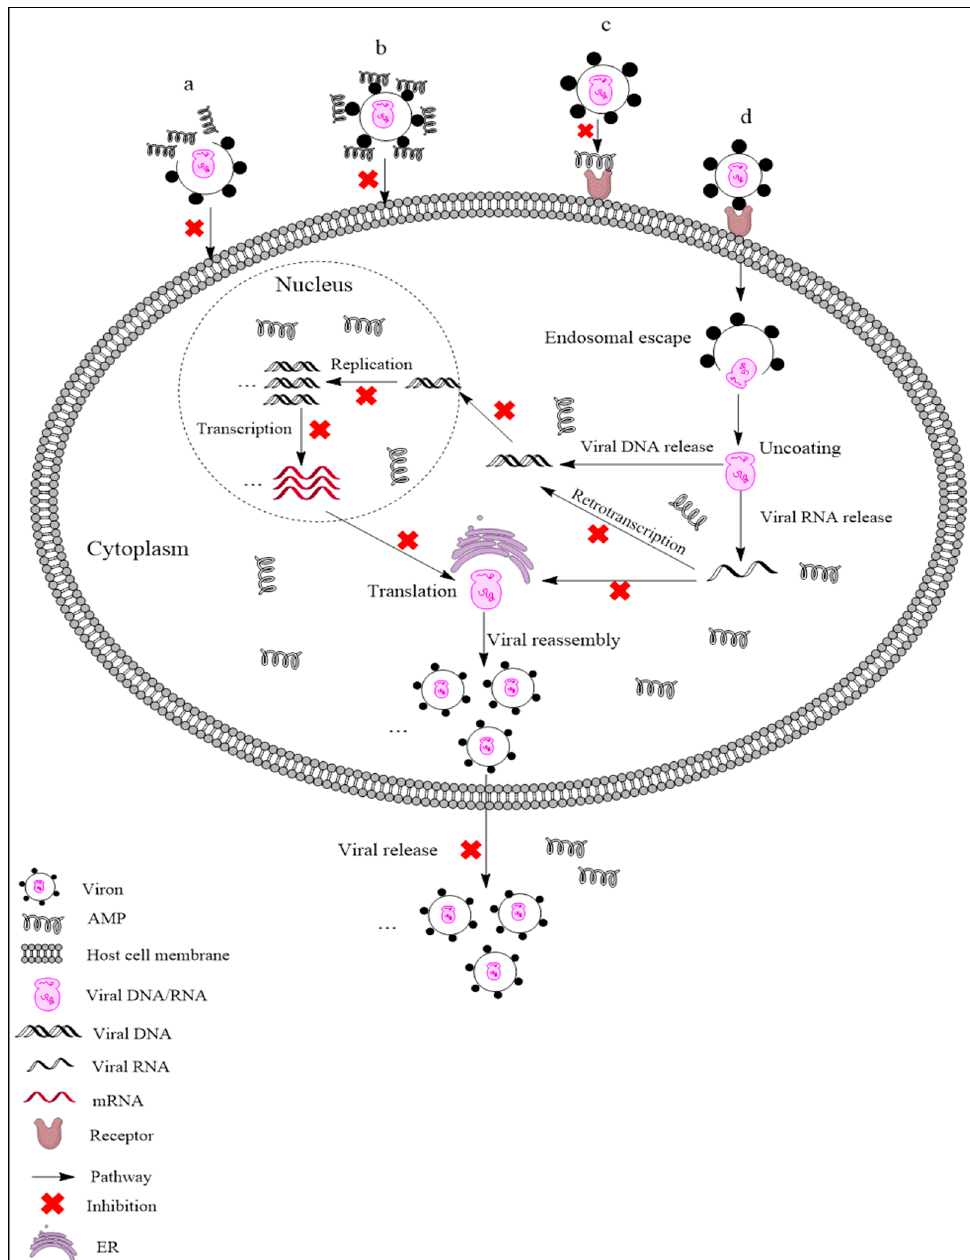
Figure 1. Antiviral mechanisms of AMPs. ( a ) AMPs inactivate a virus by destroying the viral envelope. ( b ) AMPs bind to glycoprotein on the viral envelope. ( c ) AMPs occupy a specific receptor on the host cell membrane to prevent viral attachment. ( d ) AMPs inhibit viral replication, transcription, reverse transcription, translation, and release.